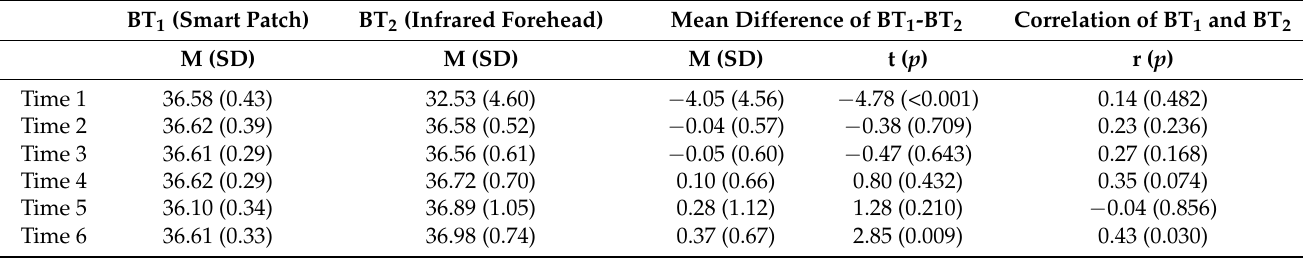
Table 1. Comparison and correlation between smart patch and infrared forehead body